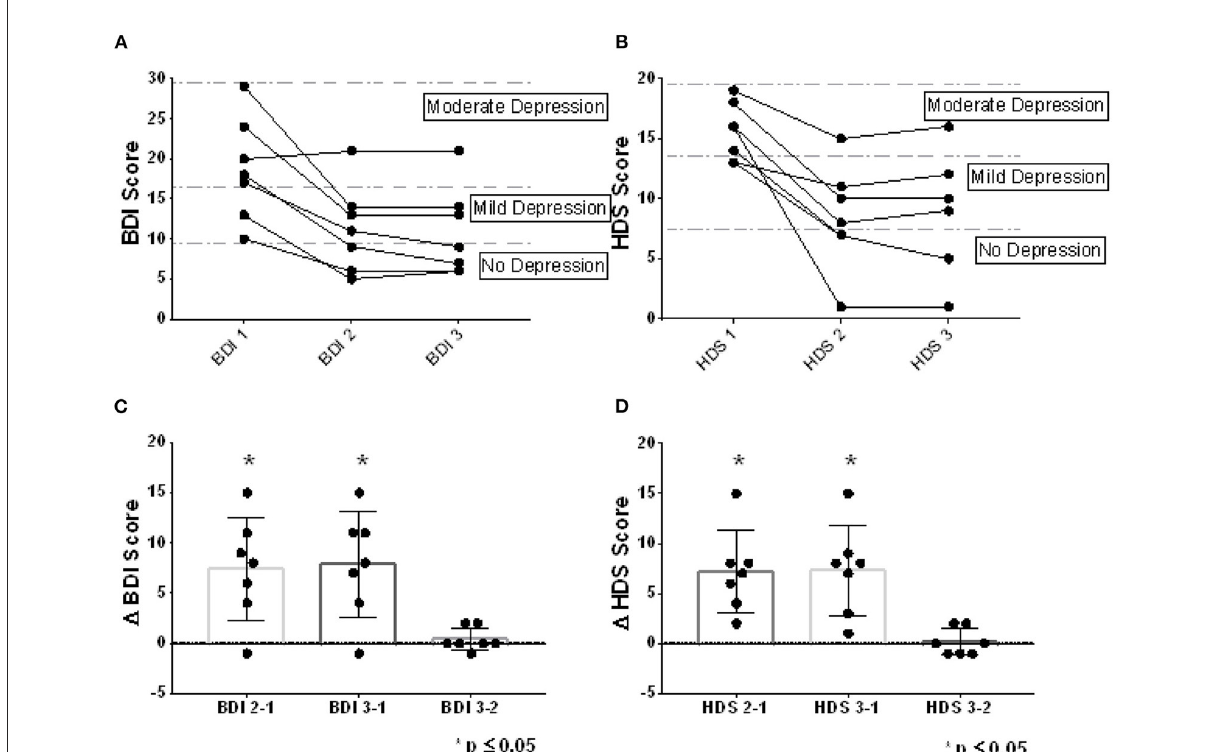
FIGURE5 Clinical changes observed. The clinical assessments at baseline, at the end of rt-fMRI NF training, and 10 days later, can be observed for the BDI-II self-report scale (A) and for the standardized clinical assessment HDRS (B) . In addition, the difference between depressive symptomatology evaluated between baseline, the end of training and 10 days after training, is observed for both BDI-II (C) and HDRS (D) . The dots represent the assessments for each patient (All points plotted. Mean ± SD. * p ≤ 0.05; One-sample Wilcoxon Signed Rank Test compared with zero, p two-tailed, 95%